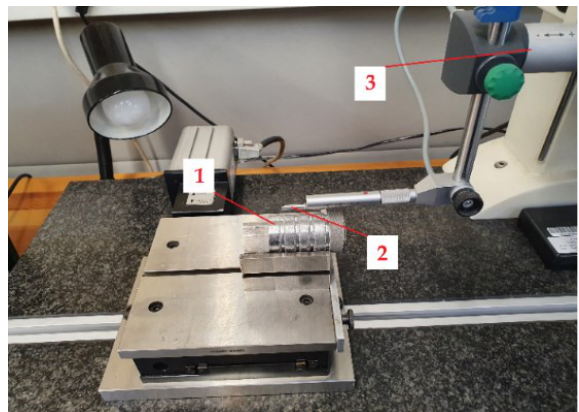
Figure 4. Three-dimensional surface roughness measurements with HOMMEL-ETAMIC T-8000: 1 — sample shaft, 2 — measurement head, 3 — profilometer.